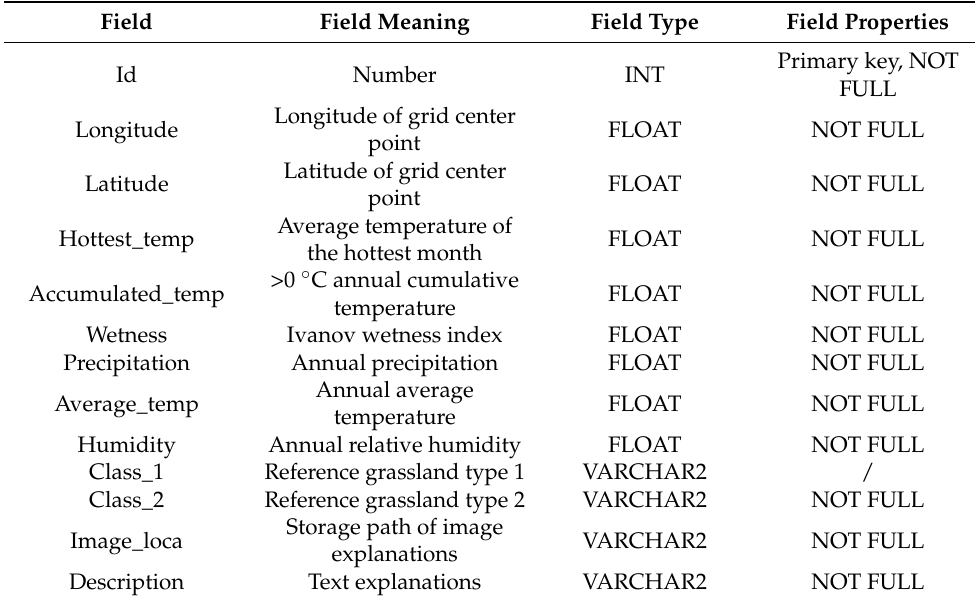
Table 2. Design of the database storage table structure. Field Field